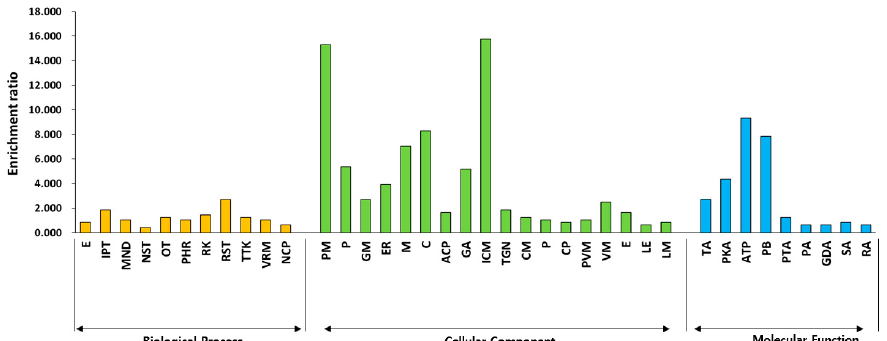
Figure 4. Gene ontology (GO) classification of DEGs shared by WT vs. slr1-d7 and WT vs. slr1-d8 lines. The x -axis shows user-selected GO terms, and the y -axis shows the enrichment ratio. Biological process: E, exocytosis; IPT, intracellular protein transport; MND, mitotic nuclear division; NST, nitric oxide mediated signal transduction; OT, oligopeptide transport; PHR, plant-type hypersensitive response; RK, response to karrikin; RST, response to salt stress; TTK, transmembrane receptor protein tyrosine kinase signaling pathway; VRM, vegetative to reproductive phase transition of meristem; NCP, nuclear-transcribed mRNA catabolic process. Cellular component: PM, plasma membrane; P, plasmodesma; GM, Golgi membrane; ER, endoplasmic reticulum; M, membrane; C, cytosol; ACP, anchored component of plasma membrane; GA, Golgi apparatus; ICM, integral component of membrane; TGN, trans-Golgi network; CM, chloroplast membrane; P, phragmoplast; CP, cytoplasmic mRNA processing body; PVM, plant-type vacuole membrane; VM, vacuolar membrane; E, endosome; LE, late endosome; EM, endosome membrane. Molecular function: TA, transporter activity; PKA, protein serine / threonine kinase activity; ATP, ATP binding; PB, protein binding; PTA, protein transporter activity; PA, potassium: proton antiporter activity; GDA, glucan endo-1,3-beta-D-glucosidase activity; SA, symporter activity; RA, ribonuclease activity.